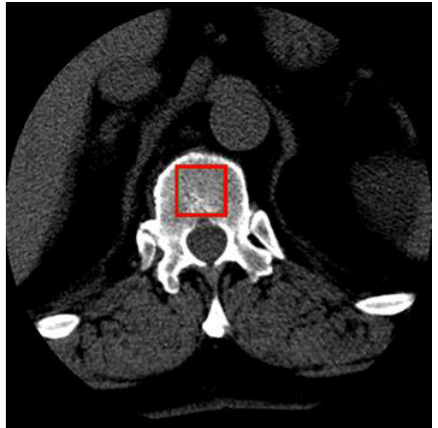
Figure 2. Manual selection of the spongy matter region.